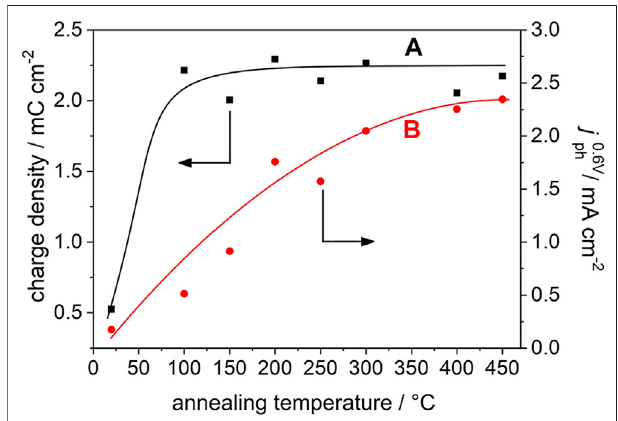
FIGURE 2 | (A) Charge accumulated during the cathodic (i.e., negative- going) scan (in the absence of UV light) in the pristine and in the annealed electrodes (squares) as extracted from data in Figure 1A . (B) Saturated photocurrents recorded at E Ag/AgCl (cid:1) 0.6 V upon illumination with polychromatic UV/Vis light (circles) as extracted from data in Figure 1C . The lines are a guide to the eye.